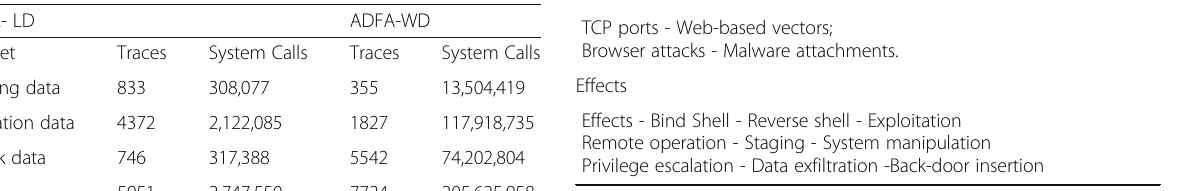
Table 9 Number of system calls traces in different categories of AFDA-LD and AFDA-WD